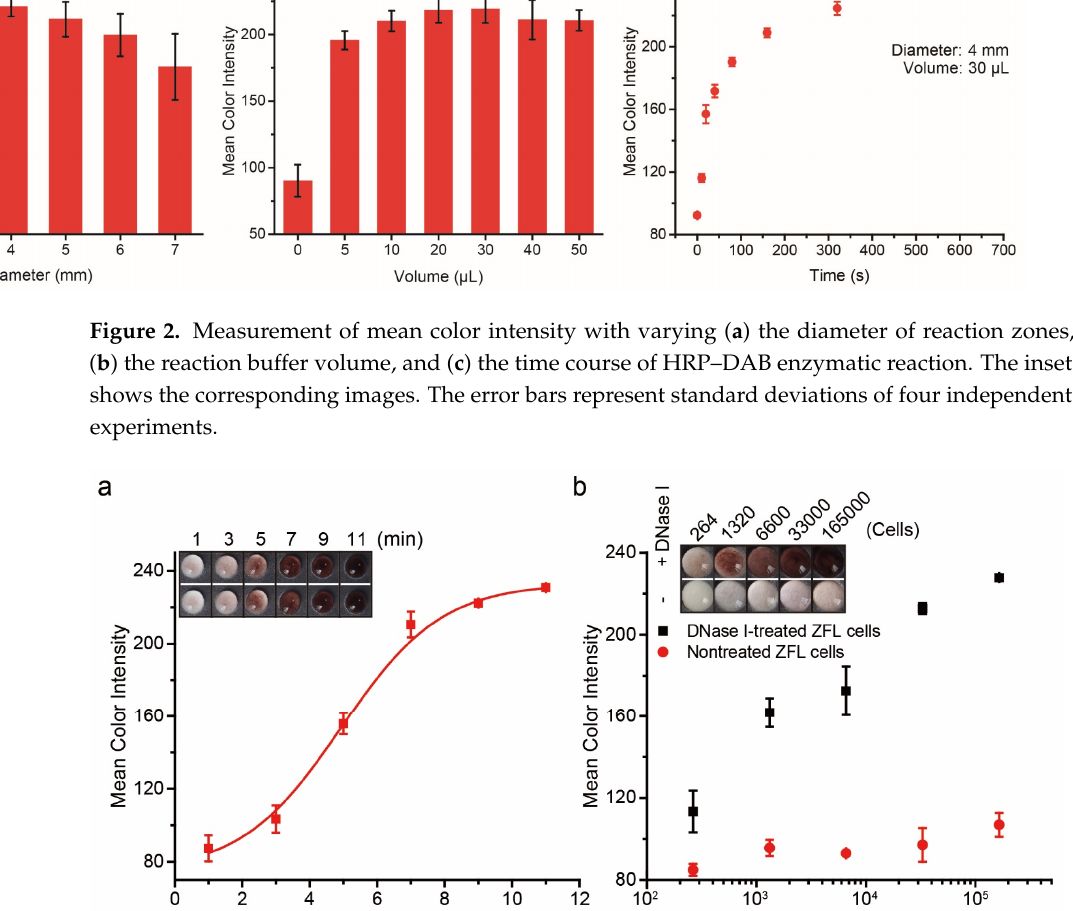
Figure 2. Measurement of mean color intensity with varying ( a ) the diameter of reaction zones, ( b ) the reaction buffer volume, and ( c ) the time course of HRP–DAB enzymatic reaction. The inset shows the corresponding images. The error bars represent standard deviations of four independent experiments.